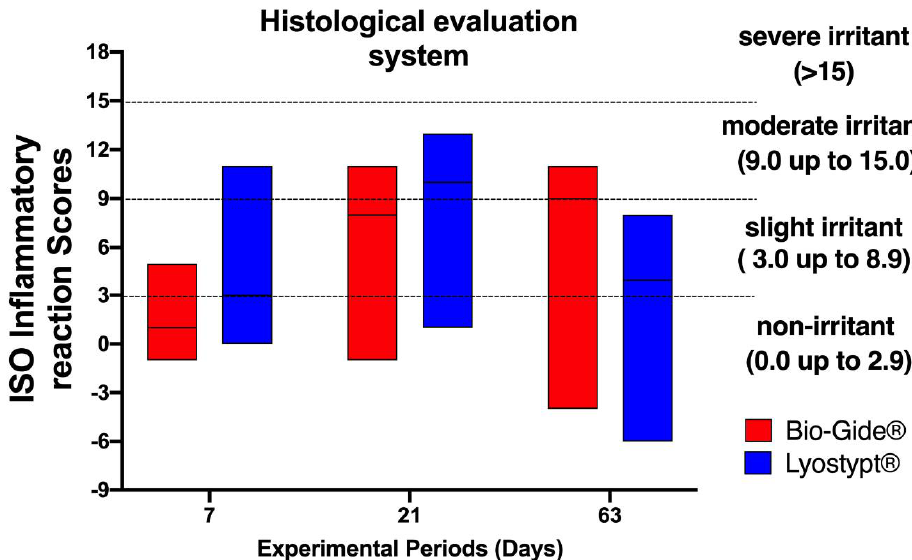
Figure 6. Score of inflammatory reaction according to ISO 10993-6:2016 of Bio-Gide ® and Lyostypt ® groups after 7, 21, and 63 days of implantation. The values obtained from Bio-Gide ® and Lyostypt ® groups were subtracted from the control (Sham group). The results are presented in the box as median, minimum, and maximum. The groups were ranked according to the criteria in ISO 10993-6:2016: non-irritant (0.0 to 2.9), slight irritant (3.0 to 8.9), moderate irritant (9.0 to 15.0), and severe irritant ( >